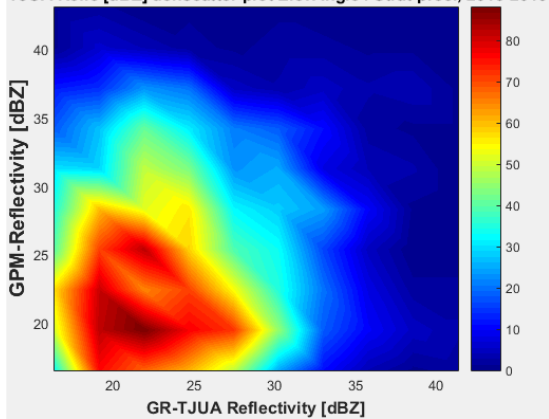
Figure 19. GPM ‐ Ka vs. NEXRAD TJUA for stratiform precipitation (angle 4).